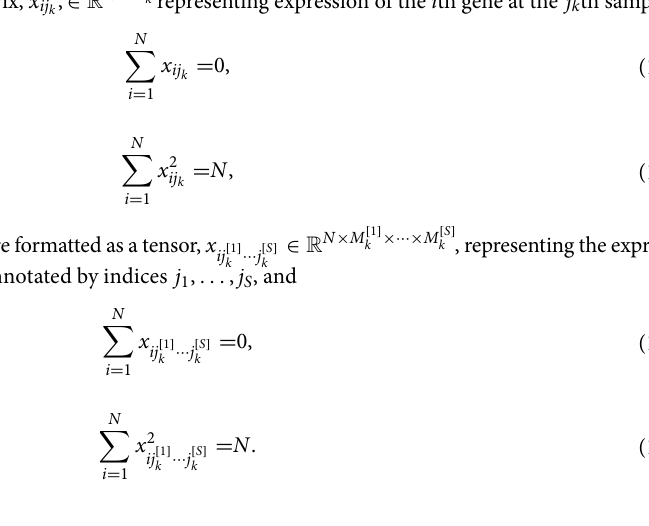
sion profiles are formatted as a matrix, x ij